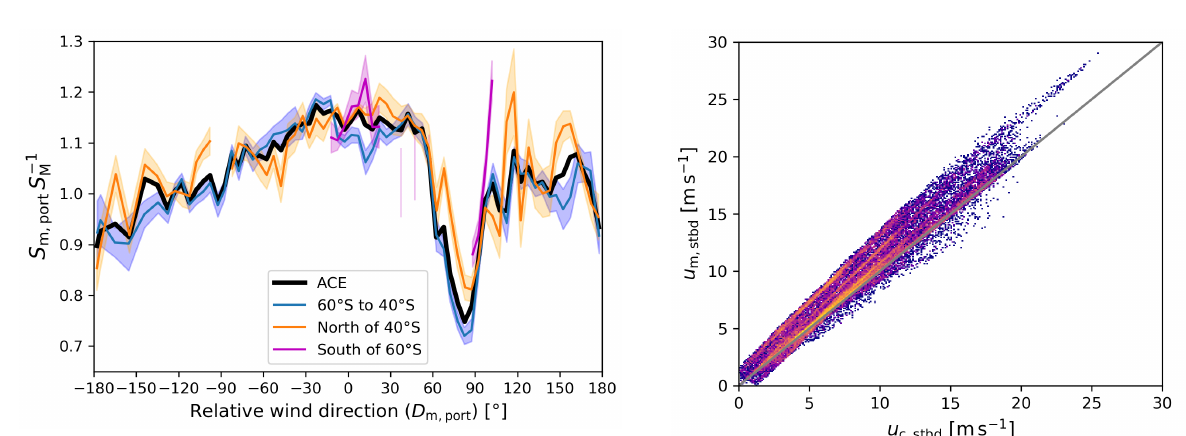
Figure 8. Bi-dimensional histogram of u m , stbd against u c , stbd . Counts are provided for a 0 . 1ms − 1 × 0 . 1ms − 1 wind speed reso- lution. The 1 : 1 line is indicated in